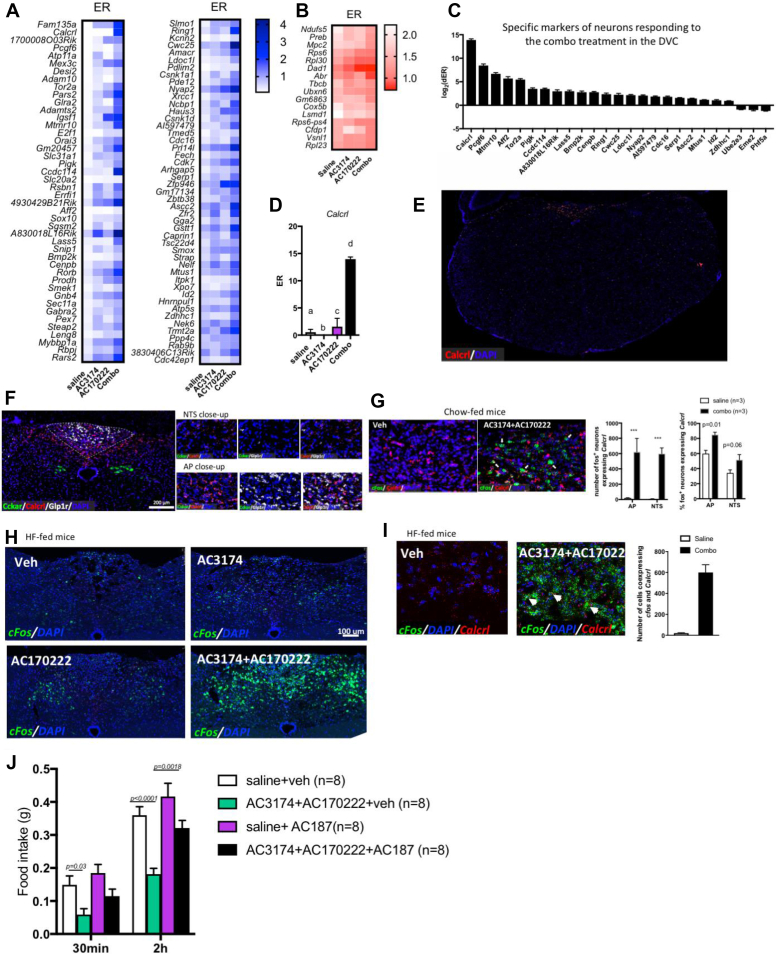
PhosphoTRAP assay identified the molecular profile and neurons activated or inhibited by the combinatorial treatment in the DVC. Enrichment ratios of transcript significantly (p < 0.01) enriched in neurons activated (A) and inhibited (B) by co-treatment with GLP-1R agonist AC3174 and CCK1R agonist AC170222, but not in neurons activated or inhibited by the monotherapies (AC3174 vs saline: p > 0.1 and AC170222 vs saline: p > 0.1). Differential enrichment ratios (C) of transcripts enriched in neurons more activated by the combinatorial therapy than monotherapies (AC3174 vs combo: p < 0.05 and AC170222 vs combo: p < 0.05). Differential enrichment ratios of Calcrl (D). Expression of Calcrl in the caudal medulla (E). Co-localisation of Cckar (green), Glp1r (white), and Calcrl (red) in the DVC (F). Co-localisation of c-fos (green) and Calcrl (red) in response to i.p. administration of the vehicle (left) or combinatorial treatment in the chow-fed mice (right) (G). Expression of c-fos (green) (H) and co-localisation of c-fos (green) and Calcrl (red) (I) in response to i.p. administration of the vehicle, AC3174, AC170222, or combinatorial treatment in the high-fat-fed mice. Feeding response to saline or AC3174 (1 μg/kg) + AC170222 (10 μg/kg) in the mice pre-treated with vehicle or AC187 (100 μg/kg) (J). Data are means ± sem. Means sharing a letter are not statistically different.